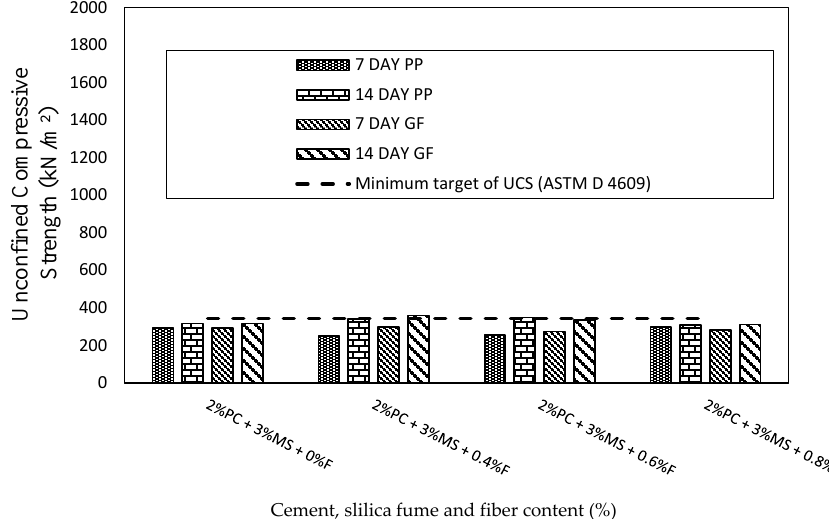
Geosciences 2020 , 10 , x FOR PEER REVIEW Figure 3. UCS results for 2%PC, 3%GGBS, 2%Lime and Fibre content after 7 and 14 days of curing.